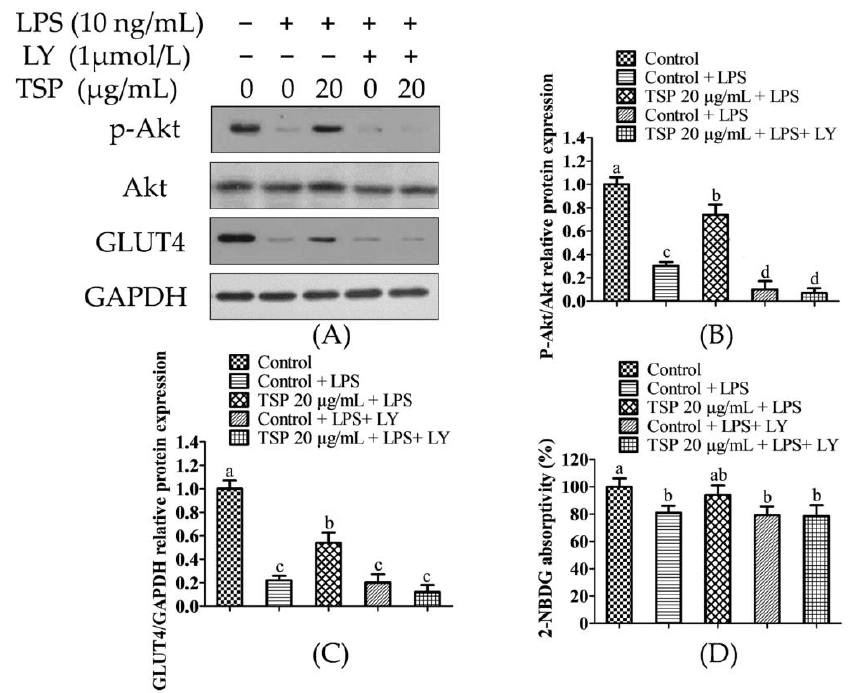
Figure 4. TSP regulates the effect of inflammation-induced insulin resistance in adipocytes under LY conditions. ( A ) The expression of p-Akt, Akt, and GLUT4 proteins was tested by western blotting. ( B ) GLUT4/GAPDH relative protein expression. ( C ) p-Akt/Akt relative protein expression. ( D ) 2-NBDG absorptivity. Data are presented as mean ± SD (n = 3); Results marked with the same letters were not significantly different ( p < 0.05).